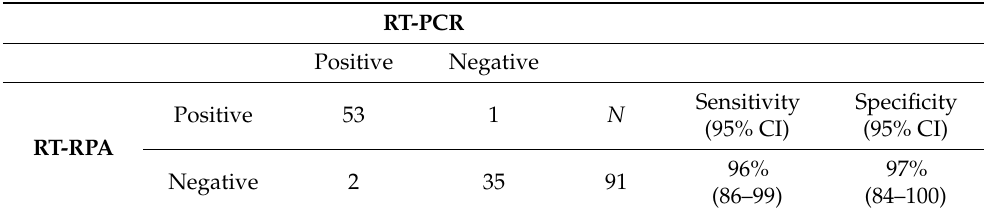
Table 1. Clinical validation of the RT-RPA